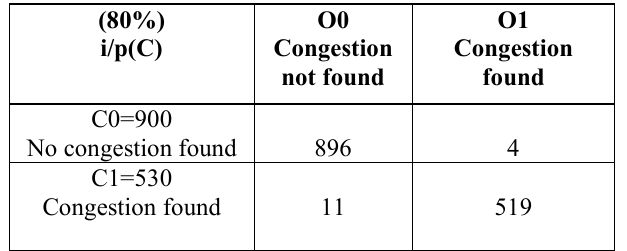
Table 2. Validation of the accuracy of the proposed